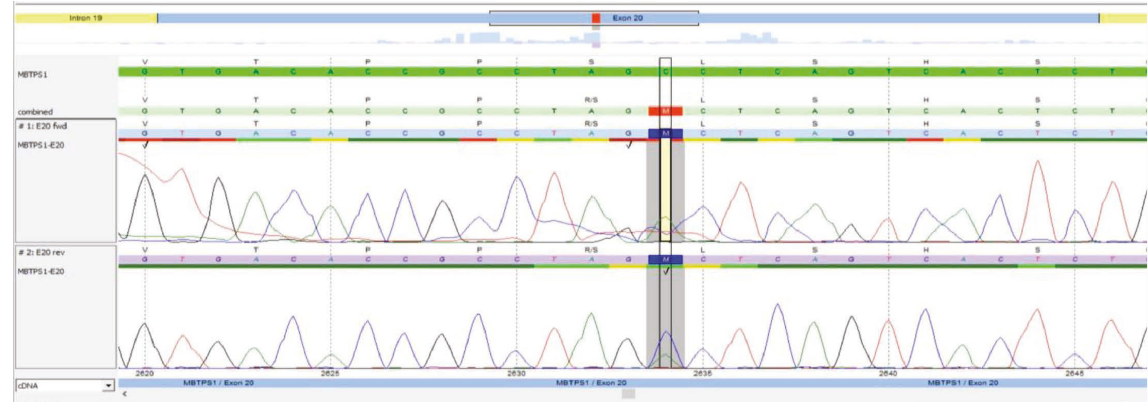
Figure 3: Molecular study of the genomic DNA of patient detected